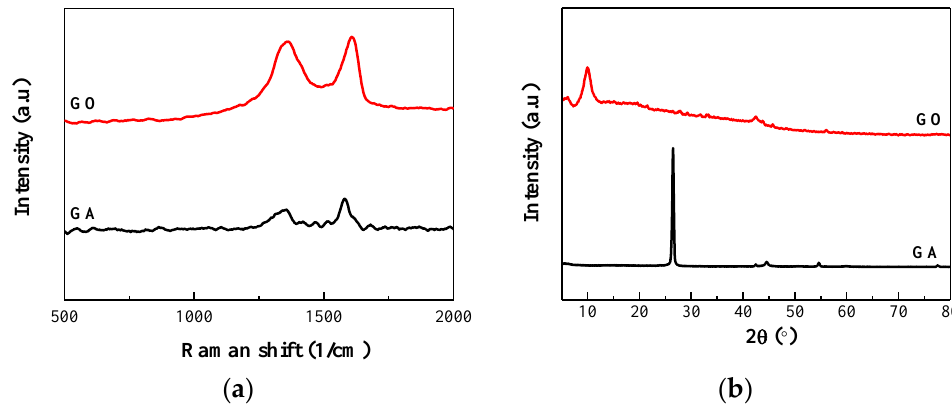
Figure 2. ( a ) Raman images of GA and GO. ( b ) XRD pattern of GA and GO.